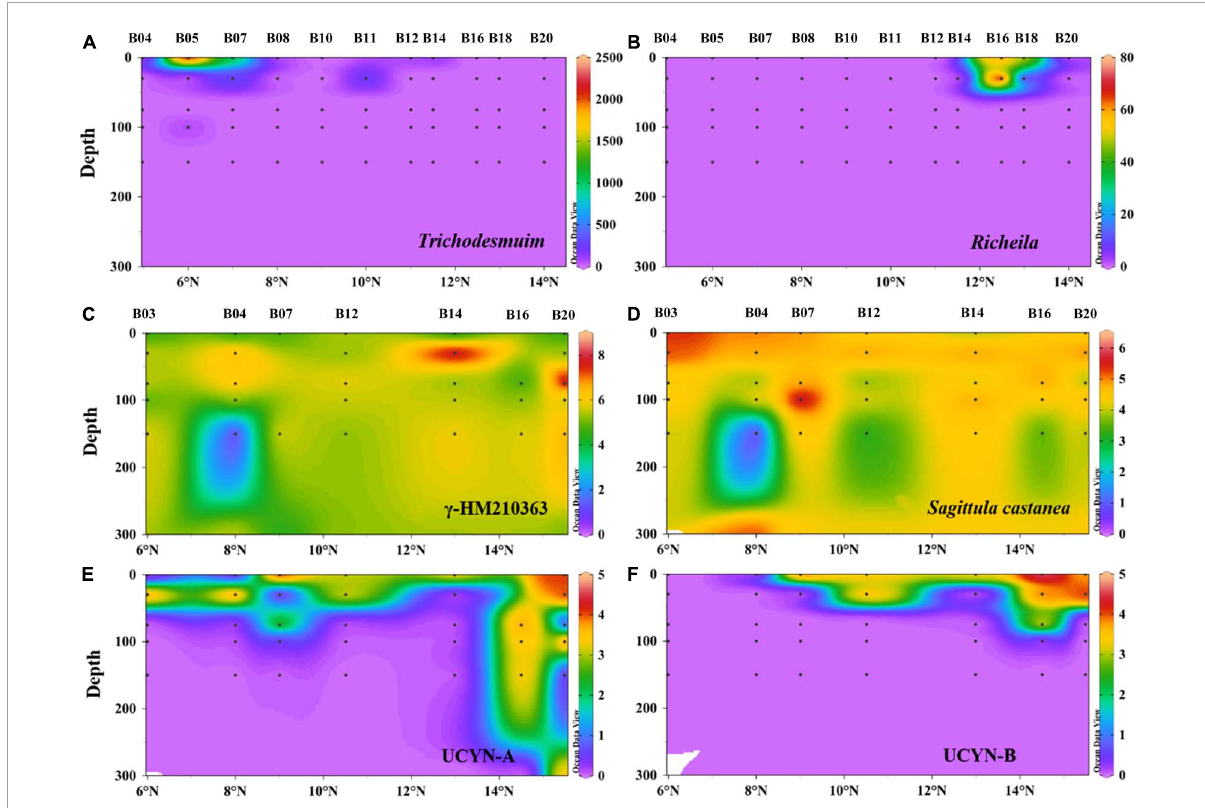
FIGURE7 Depth profiles of filamentous cyanobacteria abundance (cell L − 1 ) for Trichodesmium (A) and Richelia intracellularis (B) and nif H gene abundance (log